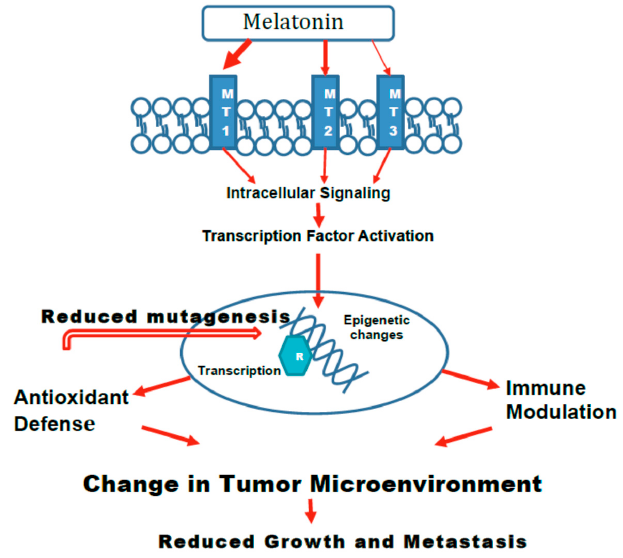
Figure 2. The effects of melatonin on carcinogenesis that Indirectly Inhibit tumors. The initial steps in the indirect action of melatonin on suppressing tumors are the same as Figure 1. Melatonin interacts primarily with MT1 receptors to activate intracellular signaling that leads to activation of transcription factors. The subsequent changes to the DNA provide up-regulation of antioxidant defenses that can reduce mutations that lead to initiation of cancer. Furthermore, the up-regulation of antioxidants and modifications to immune responses alter the microenvironment of cancer cells in a manner that reduces cancer progression and metastasis.